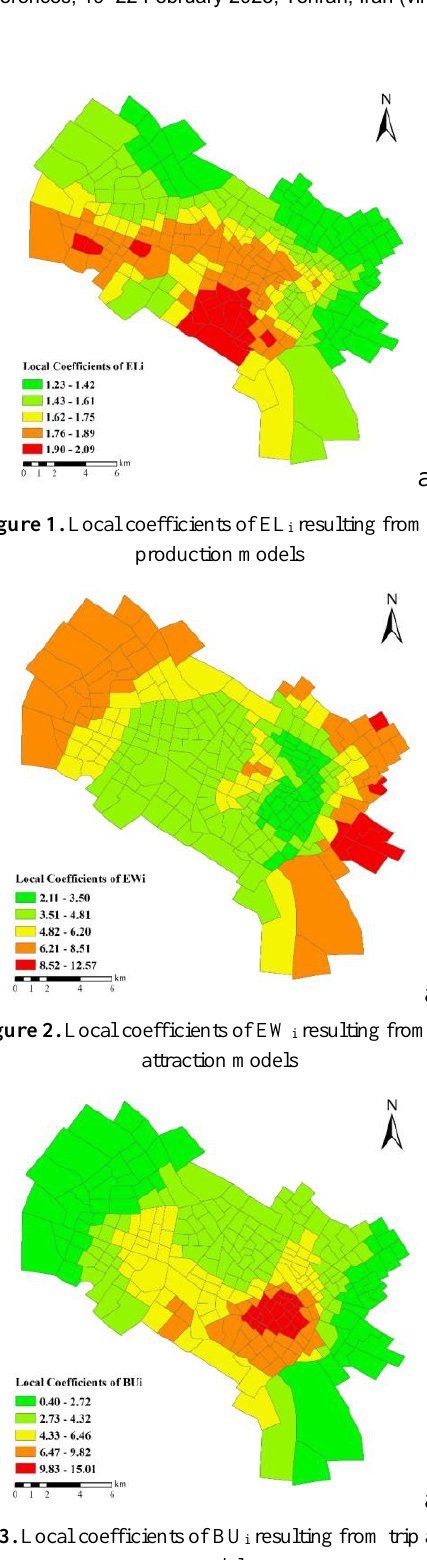
Figure 3. Local coefficients of BU i resulting from trip attraction